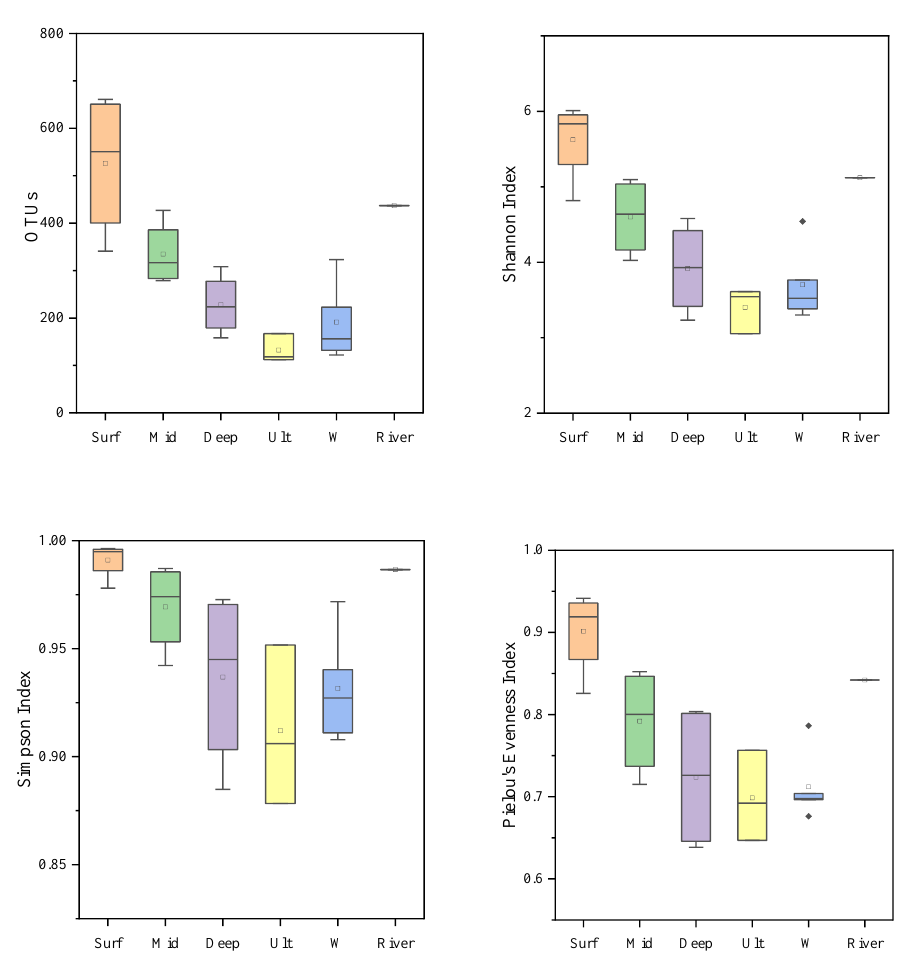
Figure 1. α -Diversity of bacterial communities in different depths.